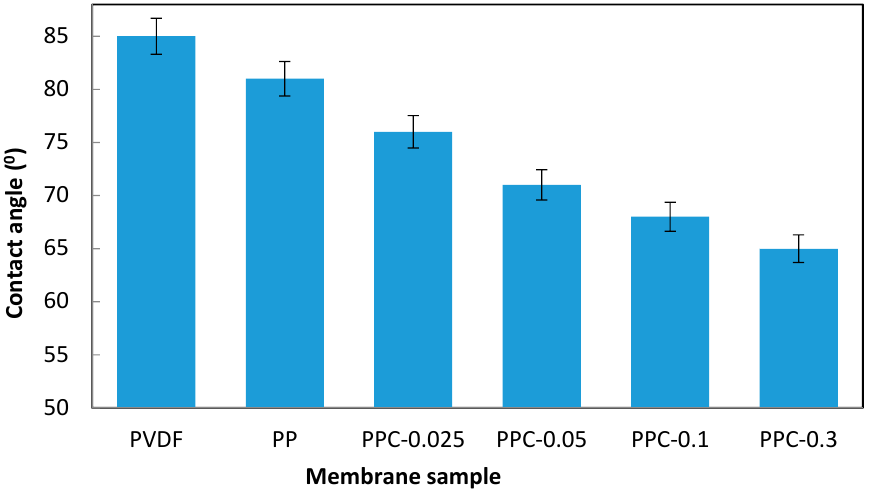
Figure 4. Hydrophilicity measurement for pristine and modified membranes.